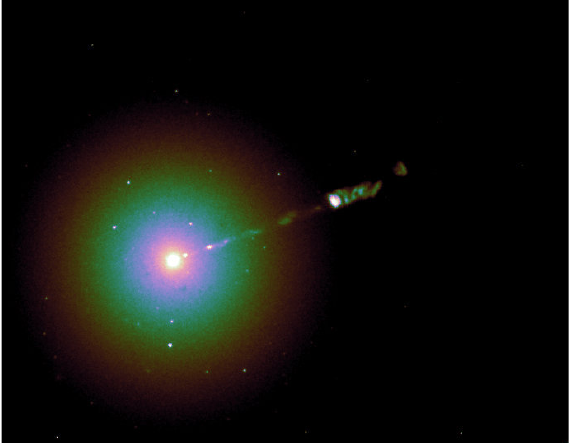
Figure 1. The super-giant elliptical galaxy M87 and the optical jet; the credit is due to Instituto de Astrofísica de